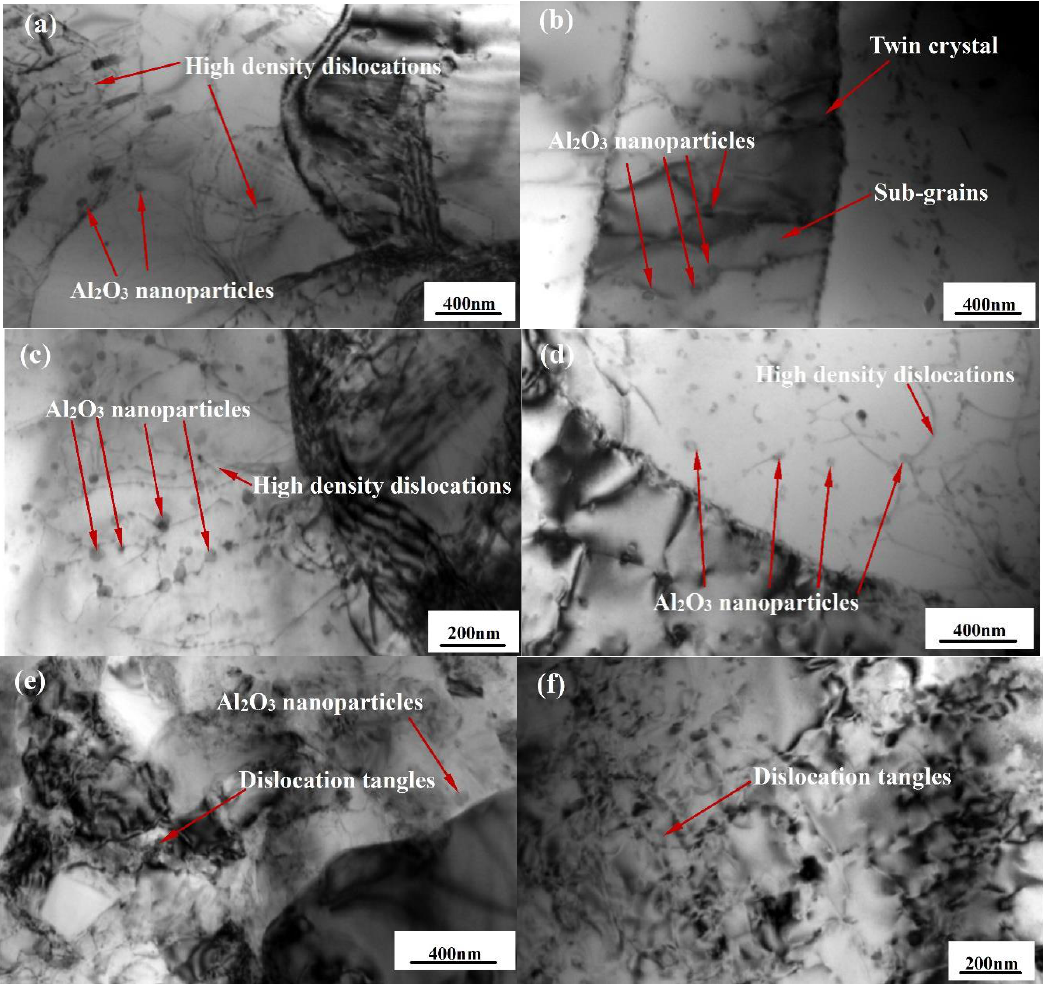
Figure 13. TEM micrographs of rheoformed composite component reinforced by 5 vol % Al 2 O 3 nanoparticles at ( a , b ) 610 °C; ( c , d ) 620 °C and ( e , f ) 630 °C. Metals 2018 , 8 , 460